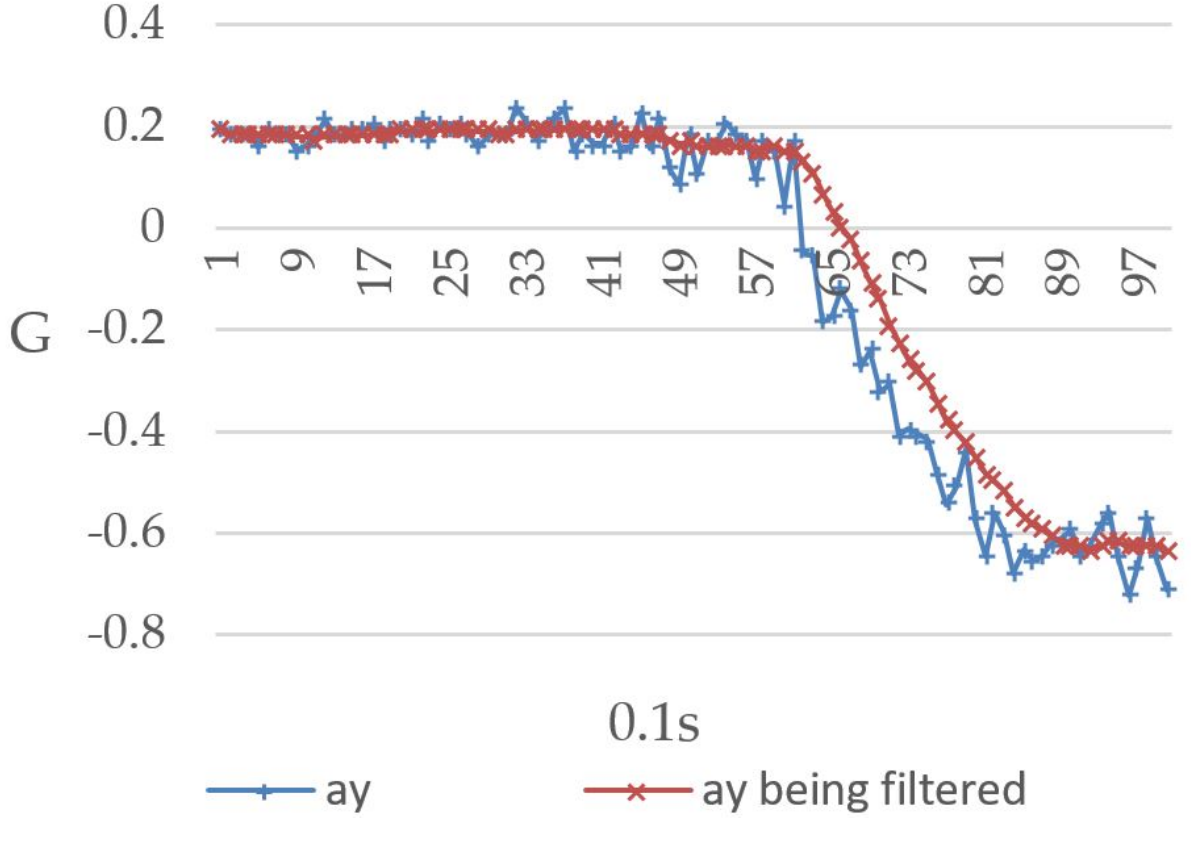
Figure 14. Triple axis accelerometer's pre-filtered y -axis values (ay) and filtered y -axis values (ay being filtered) when the user's body was tilted rightward.